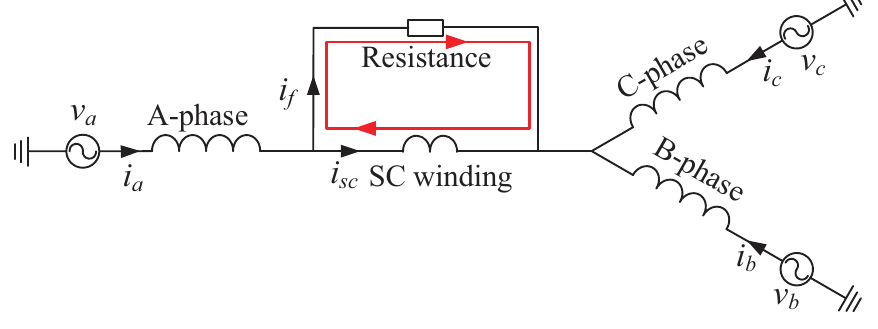
Figure 5. Equivalent circuit of the motor with